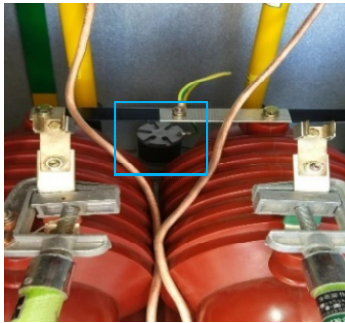
Figure 1. VT harmonic eliminator.